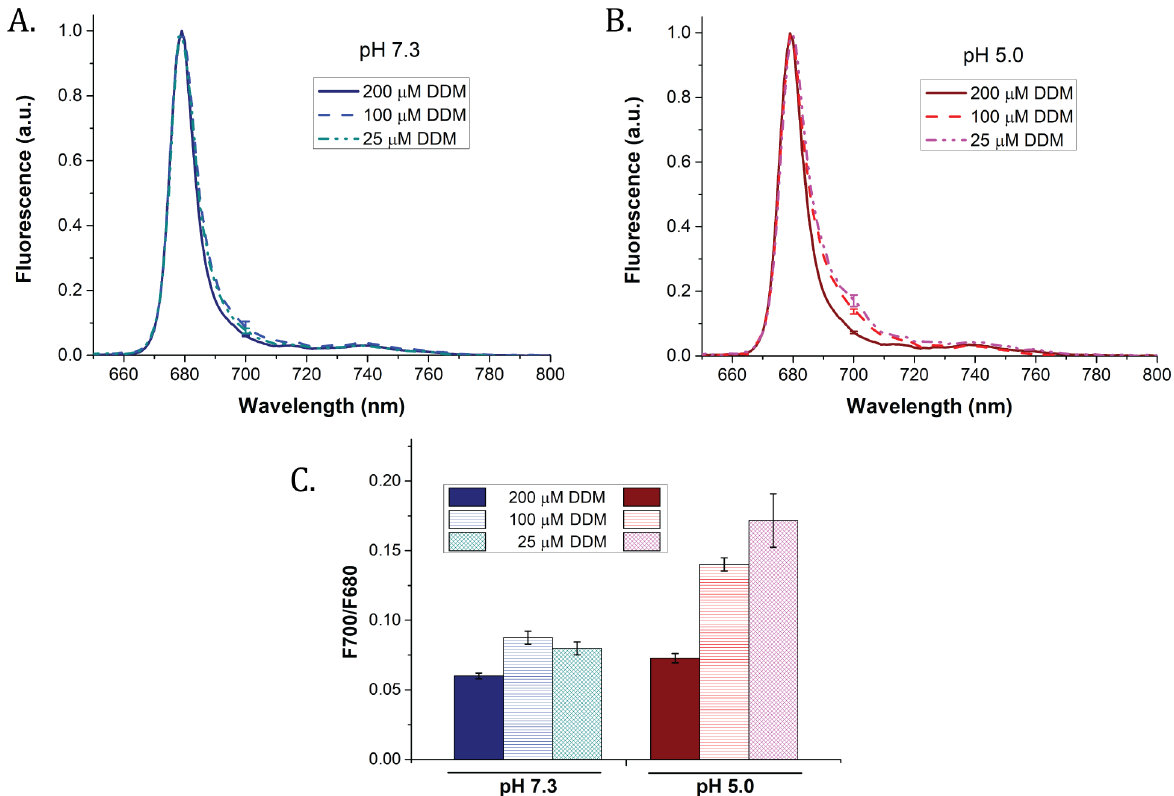
Figure 5. 77K fluorescence emission spectra of the samples used for fluorescence quenching analyses of LHCII trimers (see Figure 1). Purified LHCII were incubated at different detergents (200, 100, or 25 µM DDM) and pH values (7.3 or 5.0) as in previous experiments. ( A ) Samples at pH 7.3; ( B ) samples at pH 5.0; ( C ) ratio of the fluorescence measured at 700 nm to the fluorescence at 680 nm for each sample. Results are the average of three replicates. Error bars: SD.